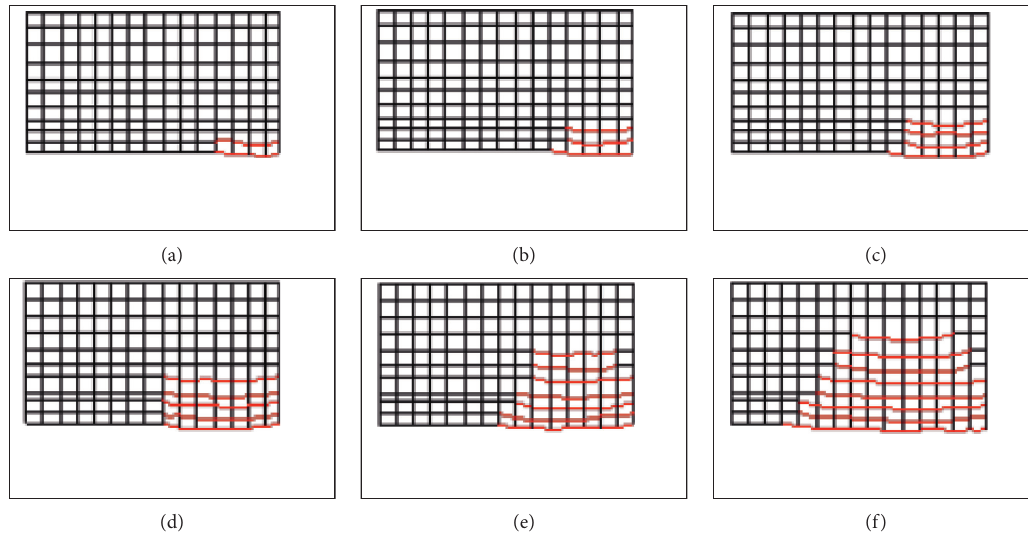
Figure 8: Subsidence map of measuring point with working face of scheme 1. (a) The first periodic pressure. (b) The second periodic pressure. (c) The third periodic pressure. (d) The fourth periodic pressure. (e) The fifth periodic pressure. (f) The eighth periodic pressure.